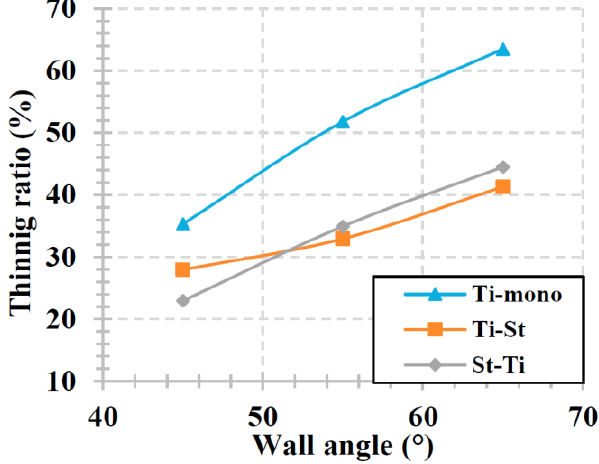
Figure 16. The effect of wall angle on the thinning ratio (initial sheet thickness t 0 = 1.5 mm, vertical step size ∆ z = 0.5 mm, St—steel) (adapted with permission from Ref. [122], Copyright 2020 The Author(s). Published by Elsevier B.V.).